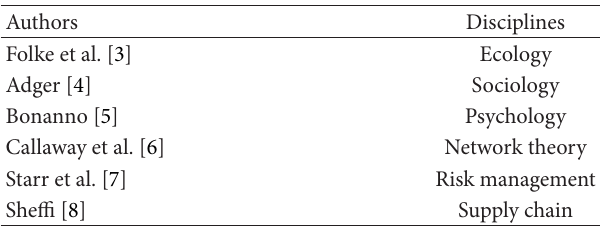
Table 1: Resilience studies in many